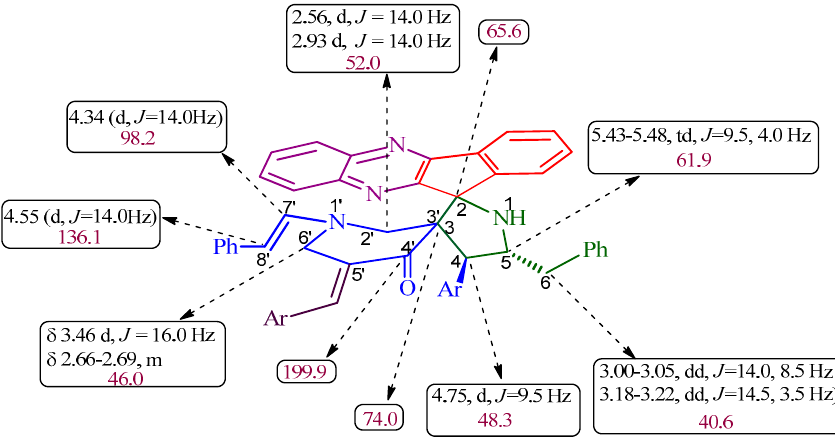
Figure 2. Selected 1 H and 13 C chemical shifts of 8j .